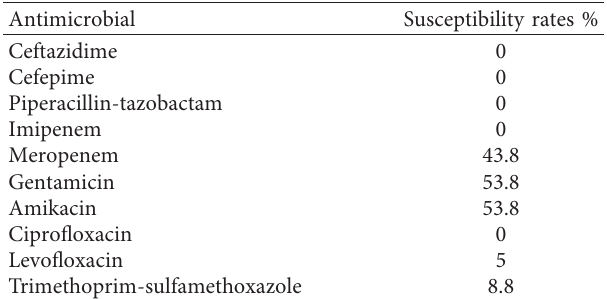
Table 3: Susceptibility profiles of 80 strains of carbapenem-re- sistant A. baumannii isolated from intensive care cases.